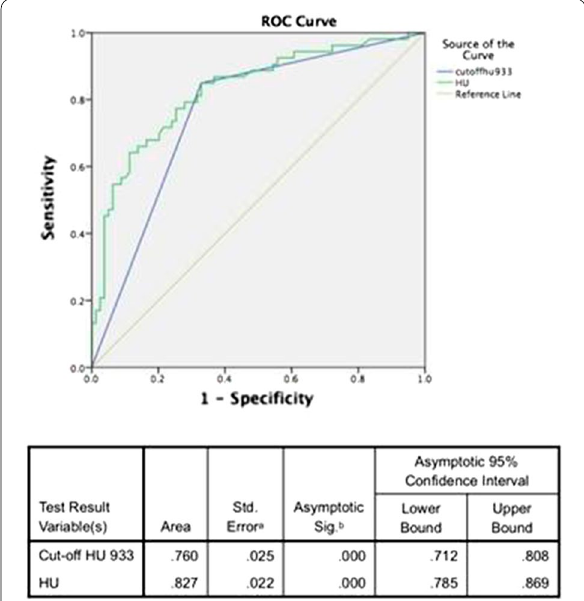
Fig. 2 ROC curve of HU predictive value for urinary leakage